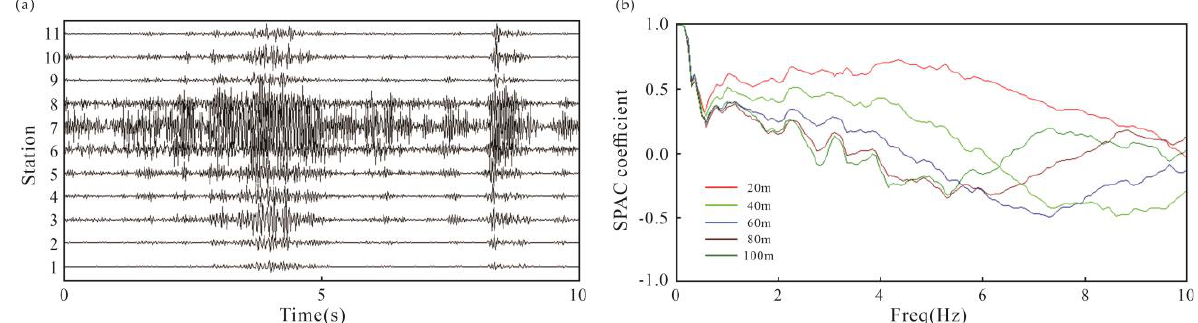
Figure 8. Two sets of parameters of WD1-1: ( a ) an example of the vertical-component records; ( b ) SPAC coefficients.